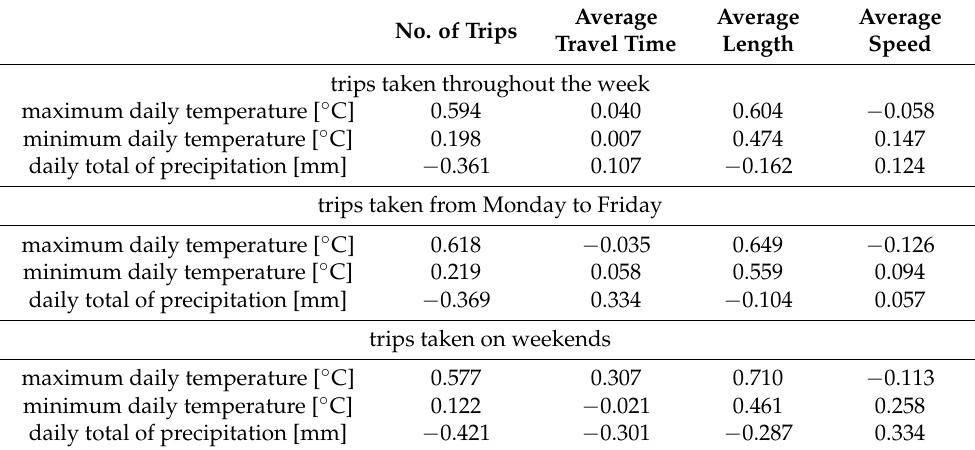
Table 2. Table of correlations between ŁPB trips and weather conditions in Ł ó d´z in 2018.